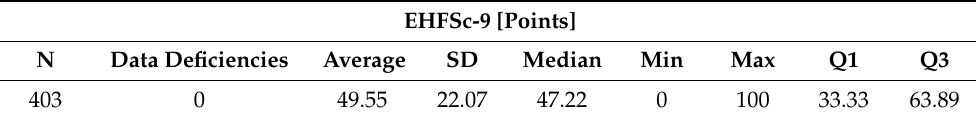
Table 2. EHFSc-9 Self-Care Questionnaire